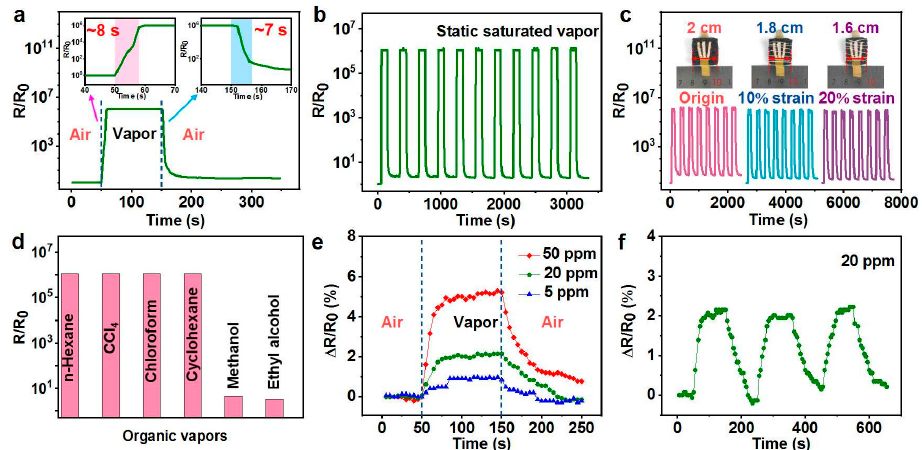
Figure 4. Figure 4. ( a ) Vapor-sensing behavior of CPS to static saturated n-hexane vapor. The inset shows the response and recovery times of CPS. ( b ) Cyclic vapor-sensing behavior of CPS toward saturated n-hexane vapor. ( c ) Responsivity of CPS maintained at different compressions. ( d ) Maximum responsivity of CPS to different saturated volatile organic vapors. ( e ) Gas-sensing results of CPS for n-hexane vapor with low concentrations (5, 20, and 50 ppm). ( f ) Gas-sensing results of CPS to 20 ppm of n-hexane vapor in successive vacuum–vapor–vacuum